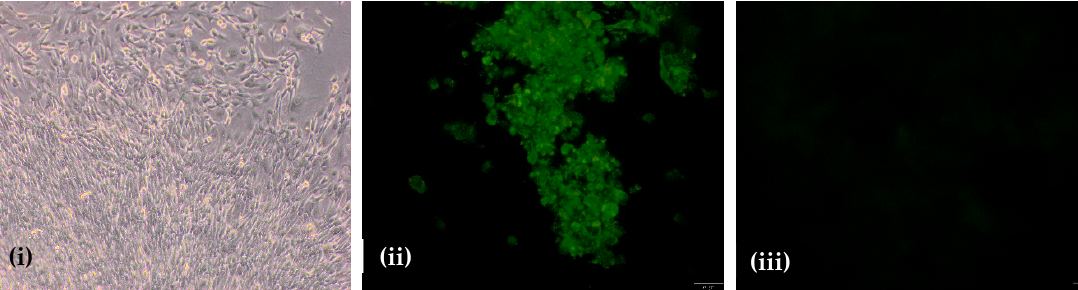
Figure 5. Cytotoxic effect of the root extracts (IC 50 concentrations) on the NIH 3T3 cell lines. ( i ) Bright field, ( ii ) AO/EB staining, ( iii ) ROS. Table 5. Pearson correlation coefficients between the phenolic compounds and cytotoxicity of the